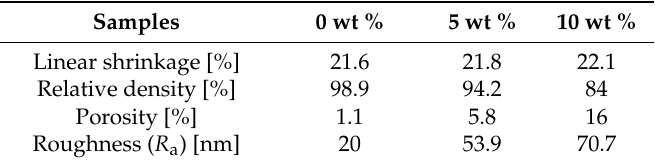
Table 1. The linear shrinkage, relative density, and porosity of samples.